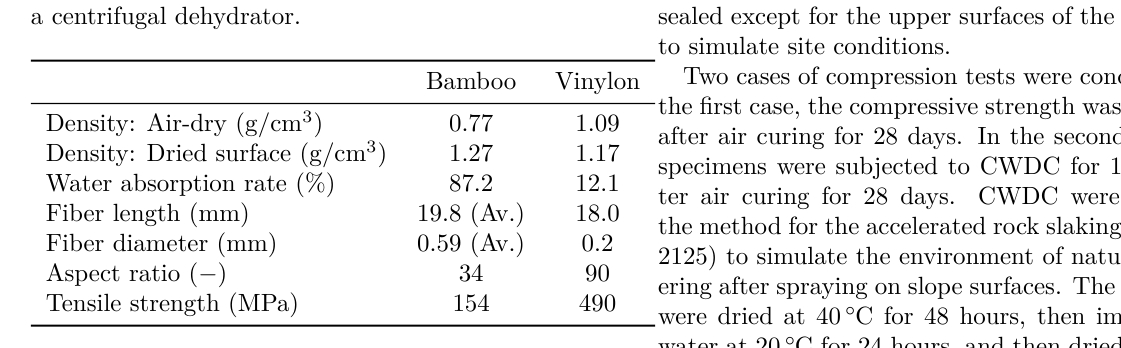
Table 1. Material properties of bamboo fiber and vinylon